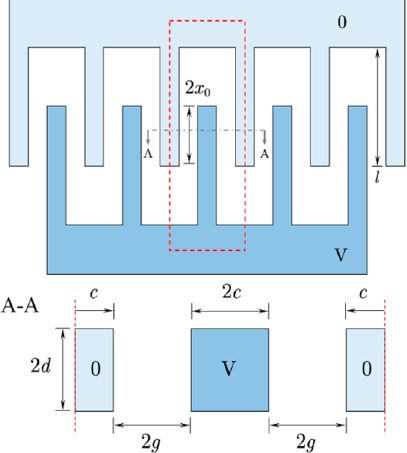
Figure 2. Drawing of the electrostatic combs defining structural